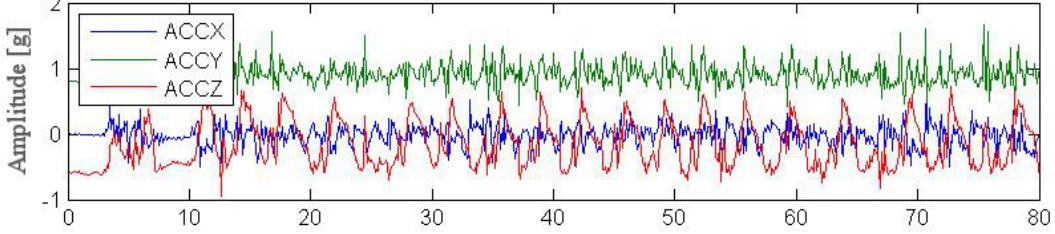
Figure 8. Data acquired from wearable accelerometer in 80s time window during digging a hole.